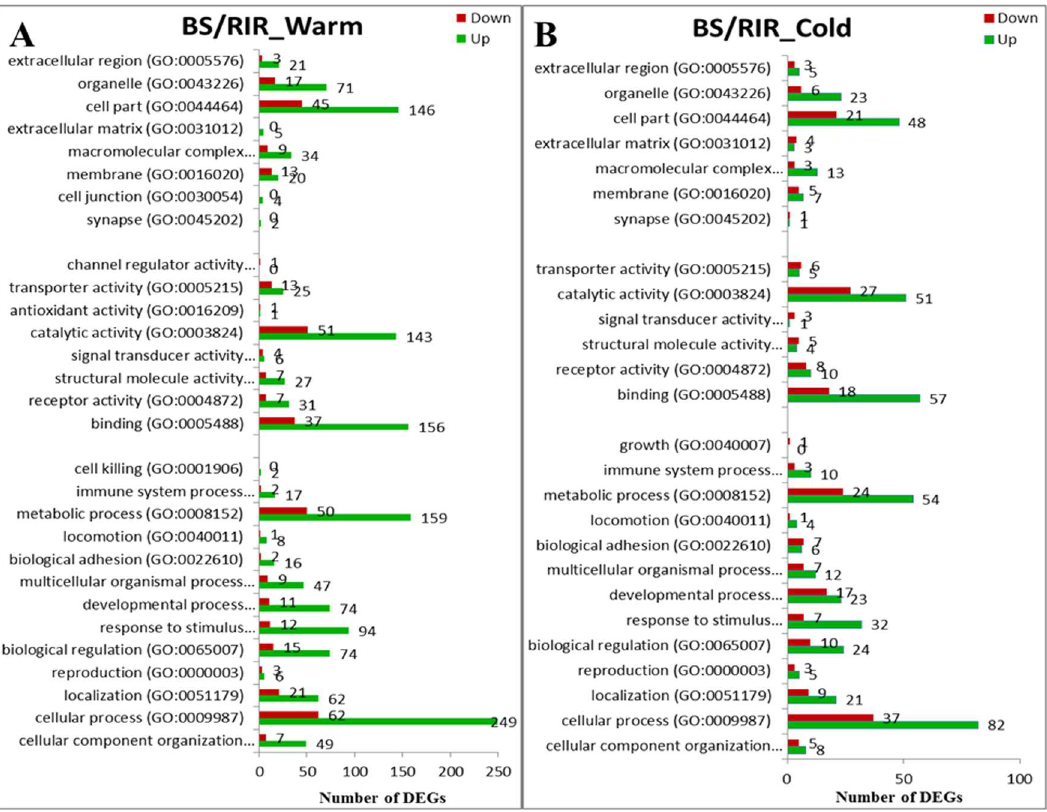
Fig 4. Functional classifications of up- and down-regulated genes for BS/RIR_Warm and BS/RIR_Cold.